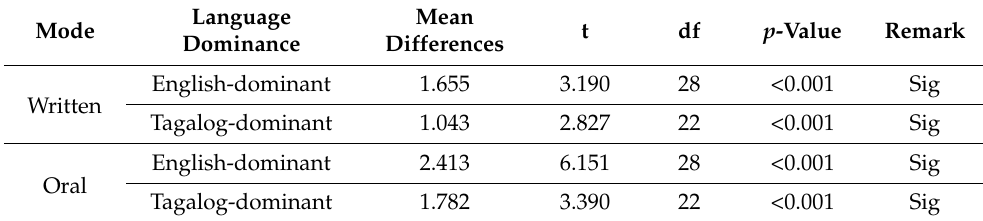
Table 8. Statistical results from paired samples t -tests for language